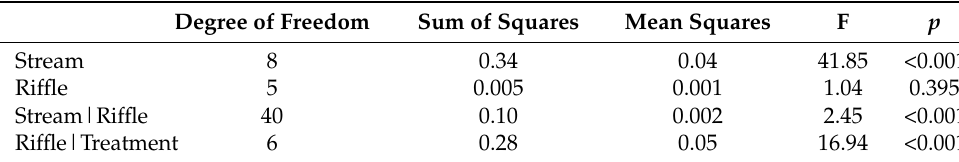
Table 2. Results of the nested ANOVA testing decomposition rate according to the streams, riffles nested within streams; treatments (coarse and fine mesh bags) within riffles. Degree of Freedom Sum of